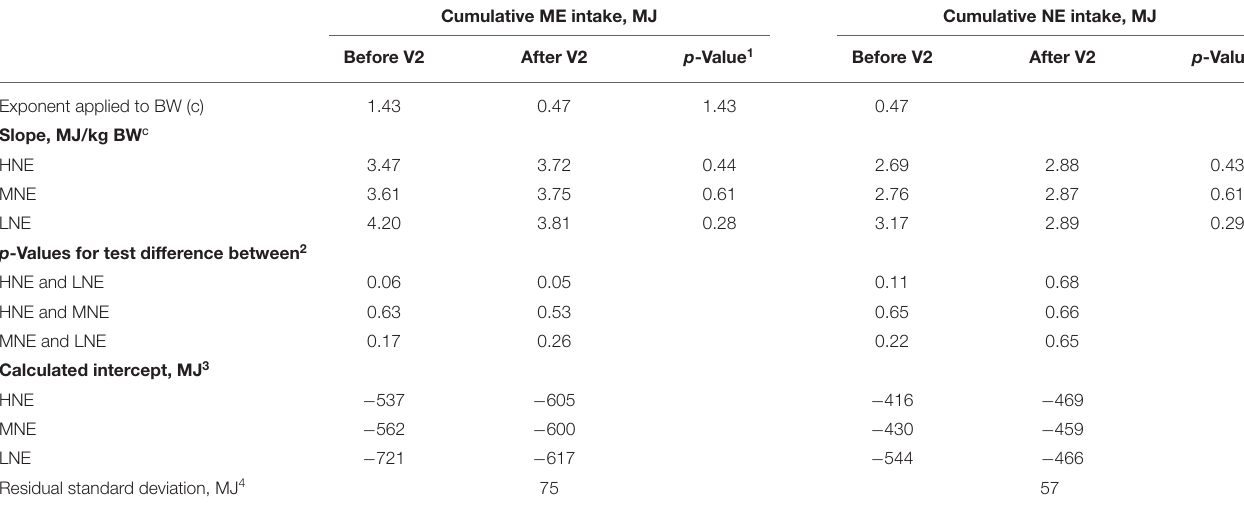
TABLE 4 | Relationship between cumulative dietary energy intake and body weight in immunocastrated pigs. Cumulative ME intake, MJ Cumulative NE intake, MJ Before V2 After V2 p -Value 1 Before V2 After V2 p -Value